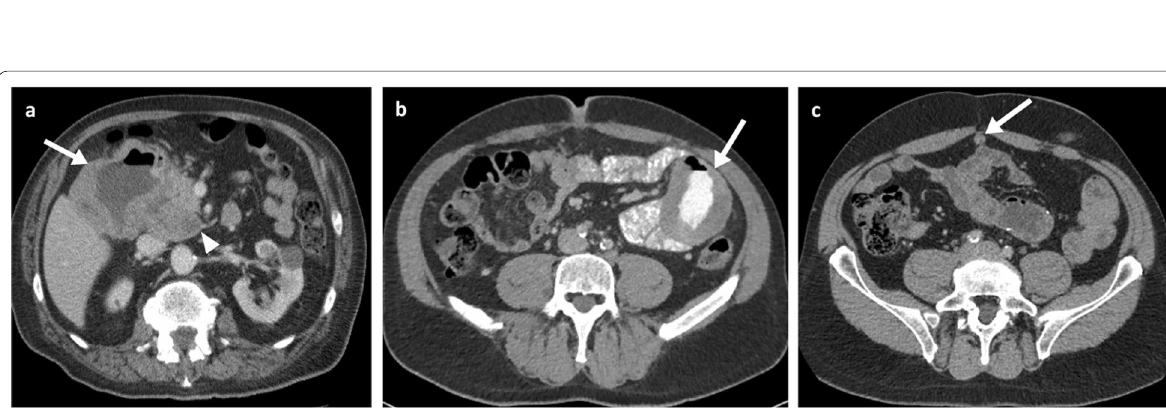
Fig. 6 Duodenal and small bowel metastases. Portal phase contrast-enhanced CT axial ( a ) of an 80-year-old male patient with a large aneurysmal metastatic melanoma mass in the duodenum (arrow) and adjacent necrotic node (arrowhead). Oral and intravenous portal phase contrast-enhanced CT axial of a 57-year-old male patient with large jejunal melanoma metastasis ( b : arrow) and anterior peritoneal nodule ( c :